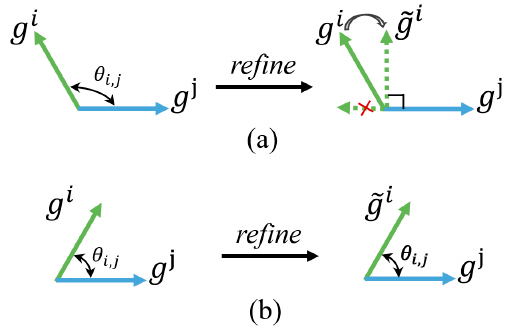
Figure 2. Process of gradient refinement. Here, 𝜃 (cid:3036),(cid:3037) represents the angle between two local gradients 𝑔 (cid:3036) and 𝑔 (cid:3037) and 𝑔(cid:3556) (cid:3036) represents the refined local gradients in client 𝑖 . ( a ) When gradients 𝑔 (cid:3036) and 𝑔 (cid:3037) are conflicting (i.e., cos𝜃 (cid:3036),(cid:3037) < 0), the gradient 𝑔 (cid:3036) is replaced with its projection 𝑔(cid:3556) (cid:3036) onto the normal plane of 𝑔 (cid:3037) . ( b ) When gradients 𝑔 (cid:3036) and 𝑔 (cid:3037) are non-conflicting (i.e., cos𝜃 (cid:3036),(cid:3037) > 0), gradient 𝑔 (cid:3036) is unchanged (i.e., 𝑔(cid:3556) (cid:3036) = 𝑔 (cid:3036) ).